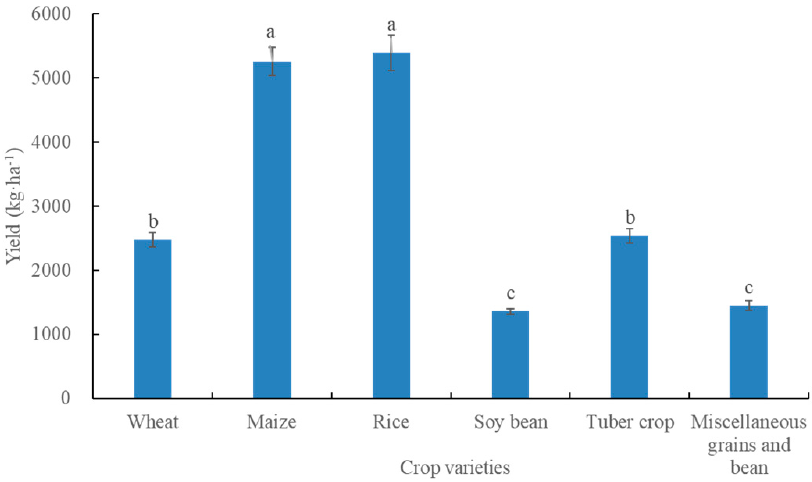
Figure 8. Yield of different crop varieties of Inner Mongolia Autonomous Region from 1980 to 2019. Note: Different letters between different grain species represent significant differences at p < 0.05.